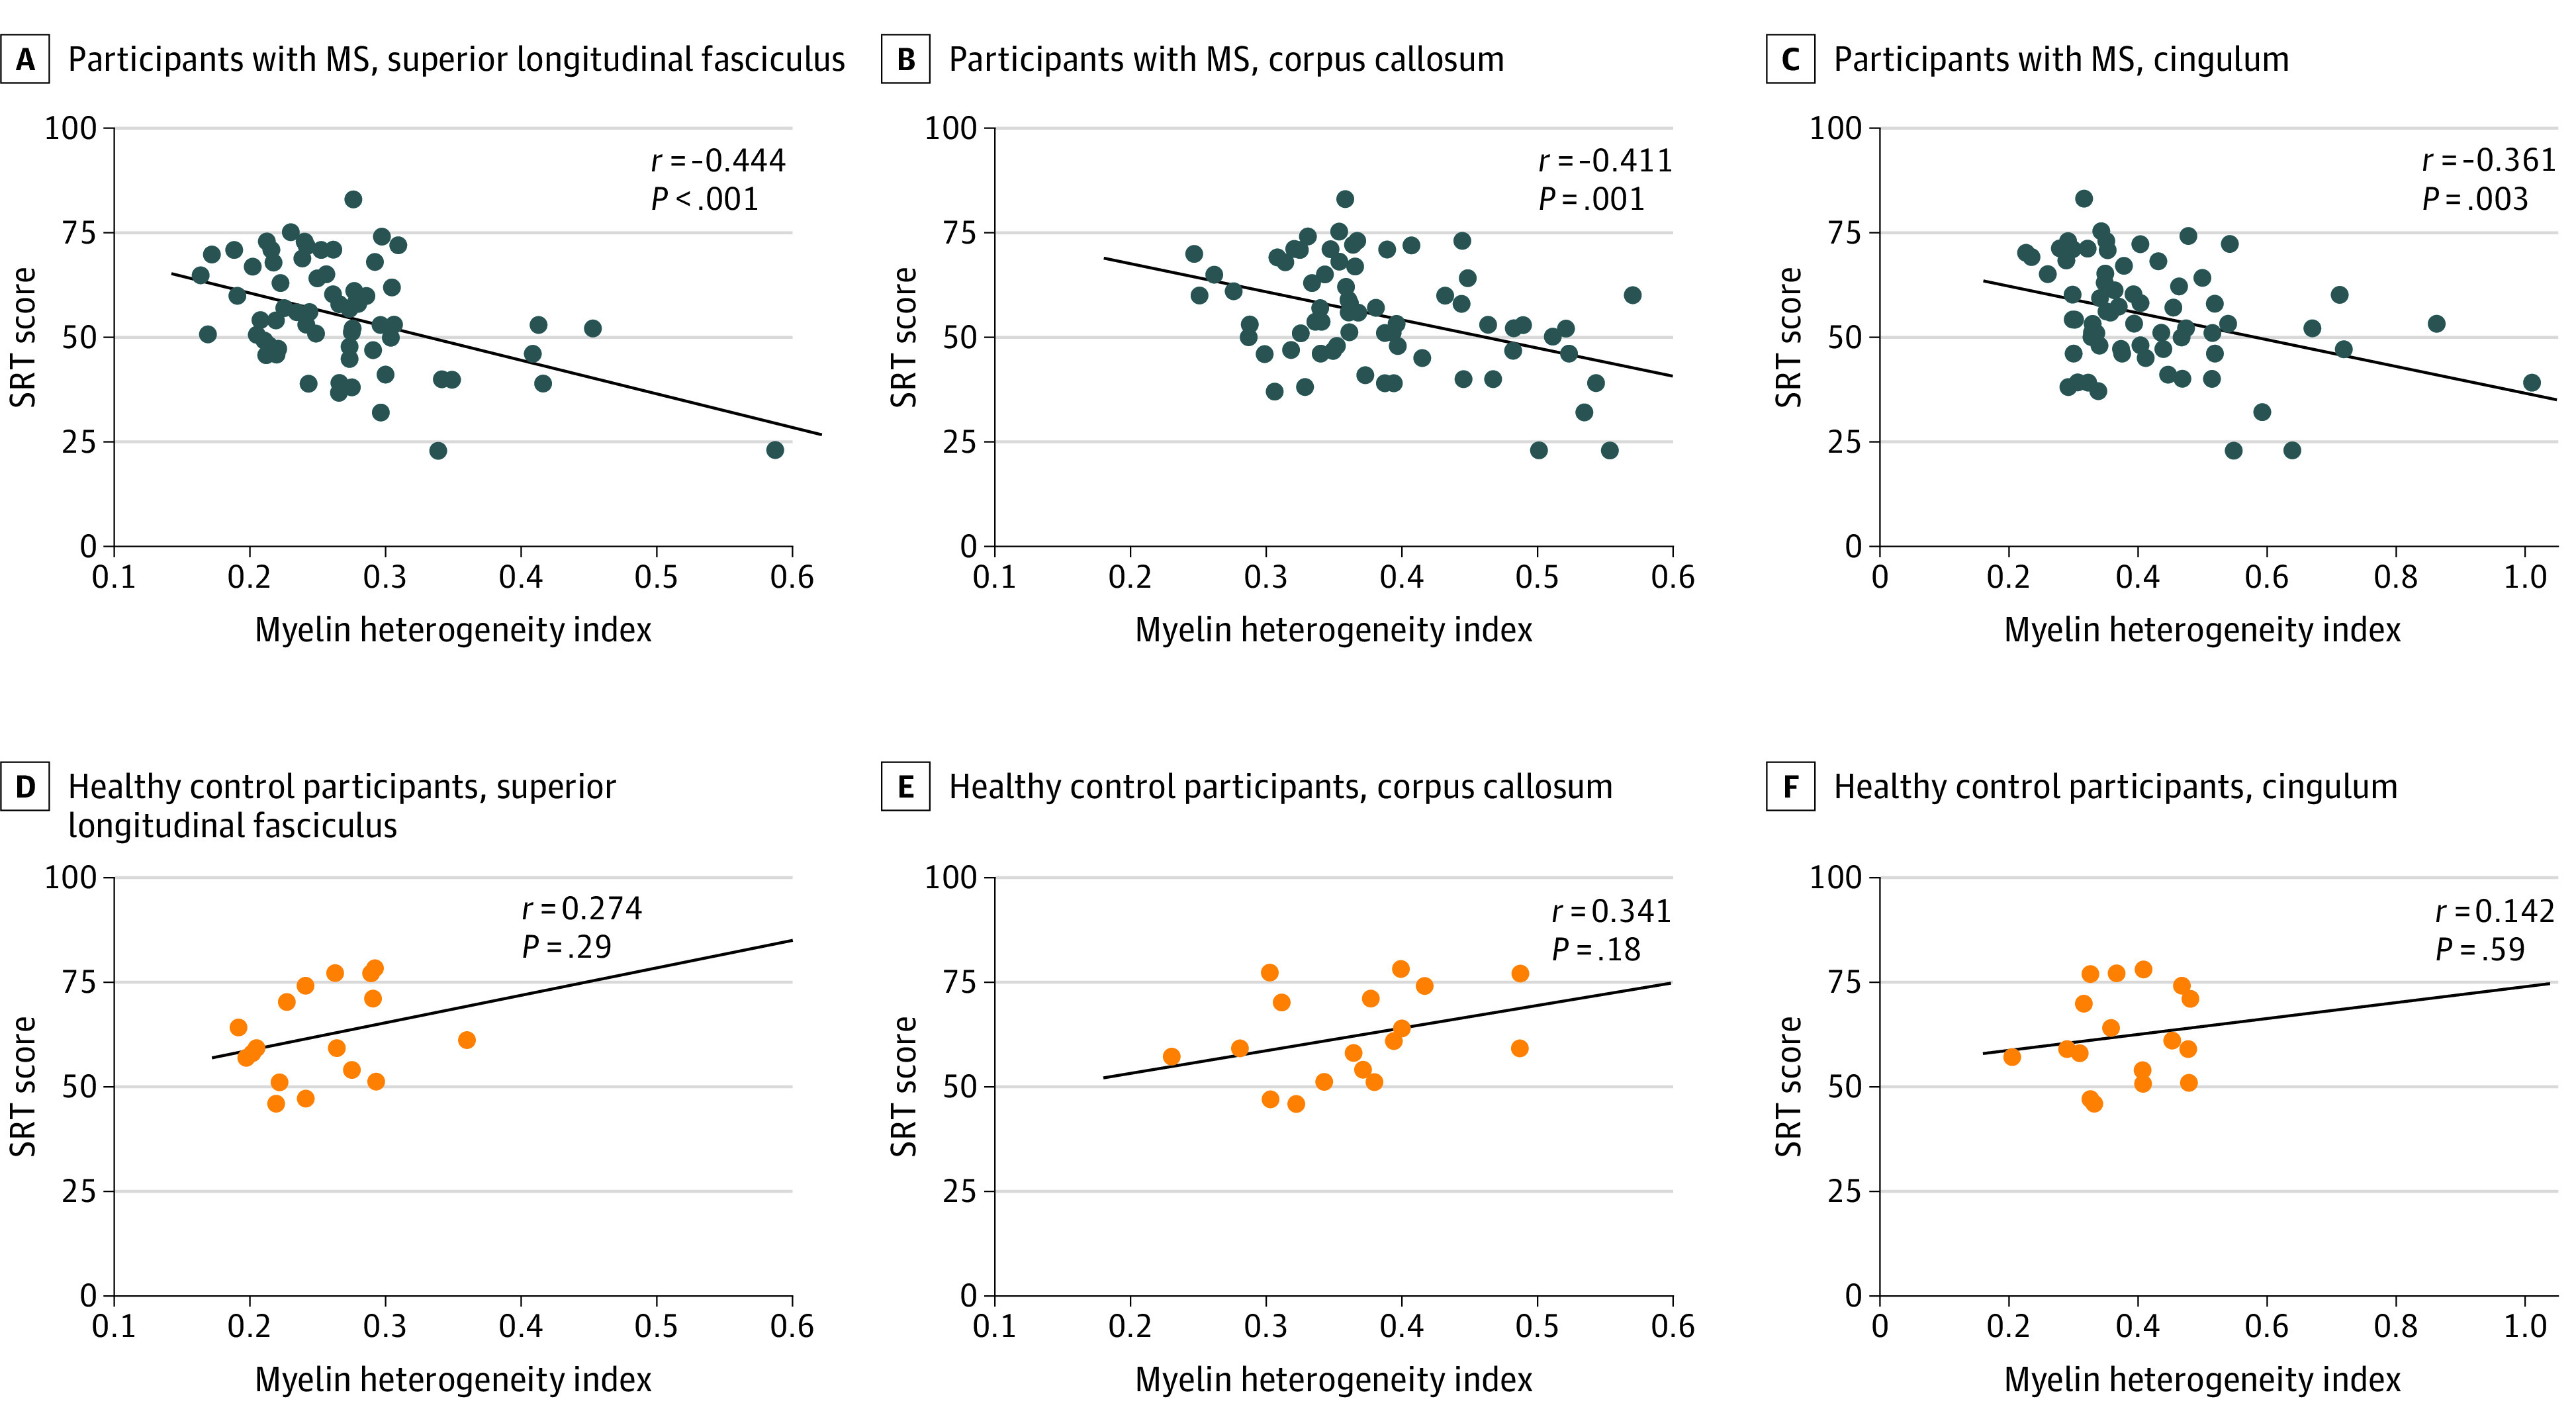
Correlations Between Selective Reminding Test (SRT) Performance and Myelin Heterogeneity IndexCorrelations between the myelin heterogeneity index in normal-appearing white matter and SRT scores are shown for participants with multiple sclerosis (MS) and controls in 3 regions of interest. Lines denote lines of best fit.